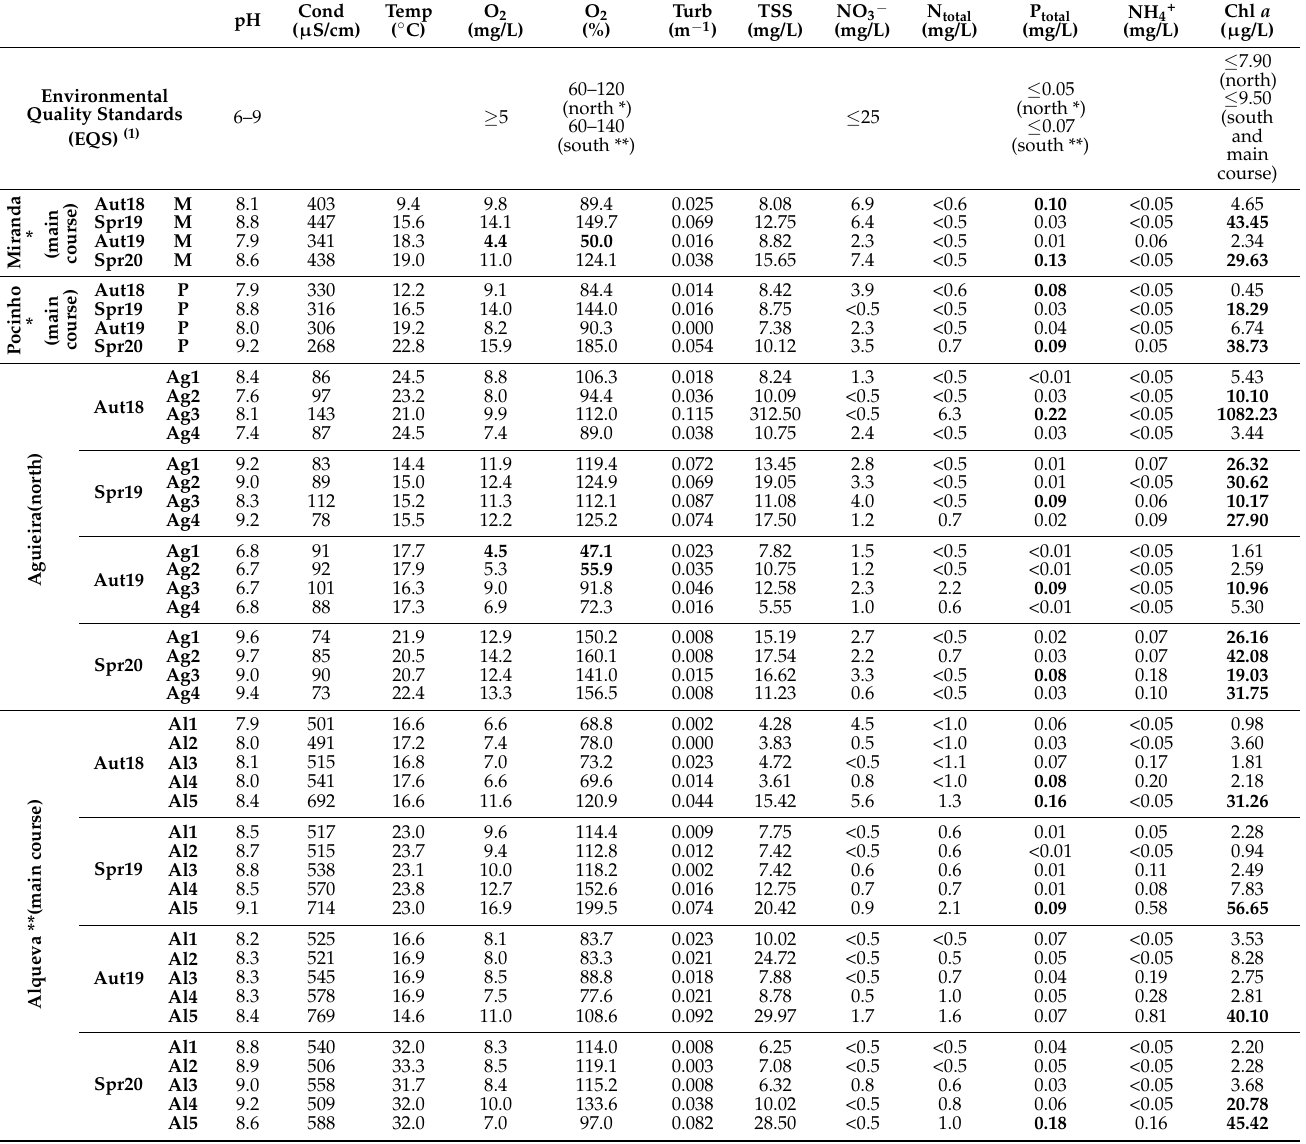
Table 1. Results of physical, chemical and biological parameters: pH, conductivity (Cond), temperature (Temp), dissolved oxygen (O 2 ), turbidity (Turb), total suspended solids (TSS), nitrates (NO 3 − ), total Kjeldahl nitrogen (N total ), total phosphorus (P total ), ammonium (NH 4+ ) and chlorophyll a (Chl a ). Sampling sites: Miranda—M, Pocinho—P, Aguieira—Ag1 to Ag4 and Alqueva—Al1 to Al5; sampling periods: autumn of 2018 (Aut18), spring of 2019 (Spr19), autumn of 2019 (Aut19) and spring of 2020 (Spr20). The bold values represent the values outside the environmental quality standards. * stands for physical and chemical EQS of north type. ** stands for physical and chemical EQS of south type; (1)